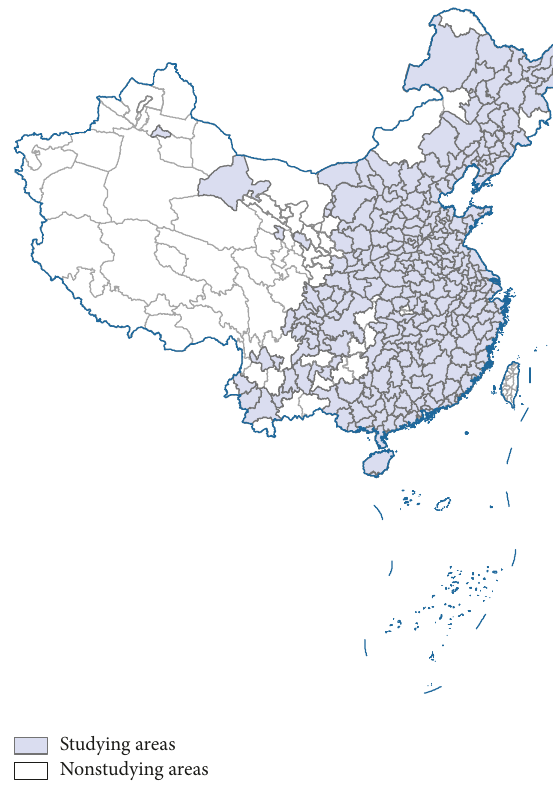
Figure 1: The study